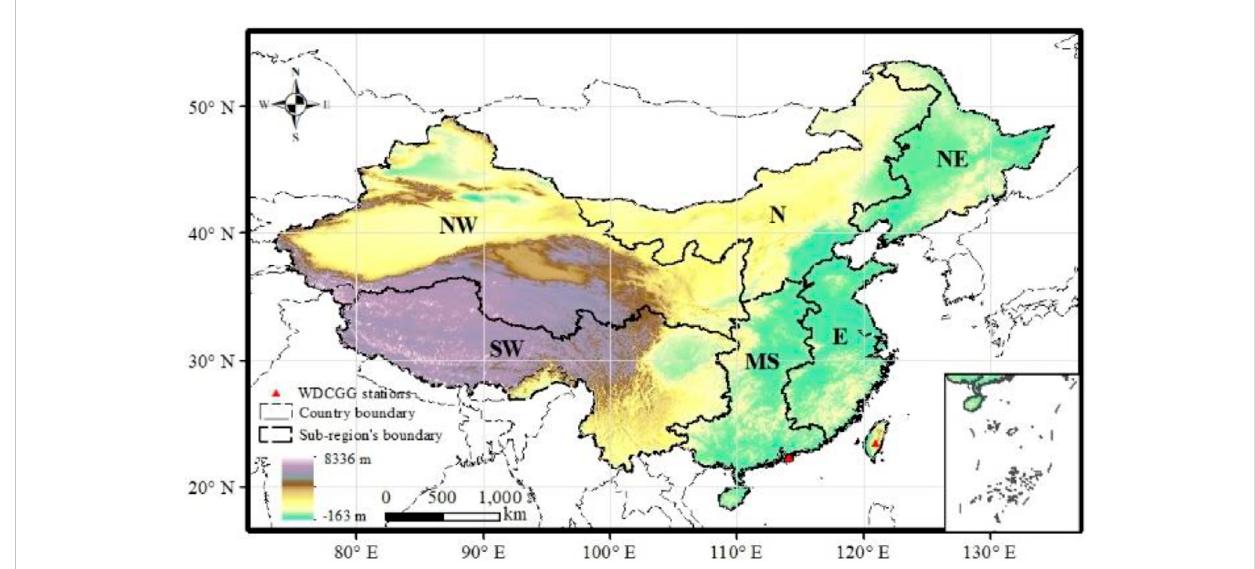
FIGURE 1 Geographic location and the six sub-regions of China. (NW is Northwest China, SW is Southwest China, N is North China, MS is Middle and South China, NE is Northeast China, and E is East